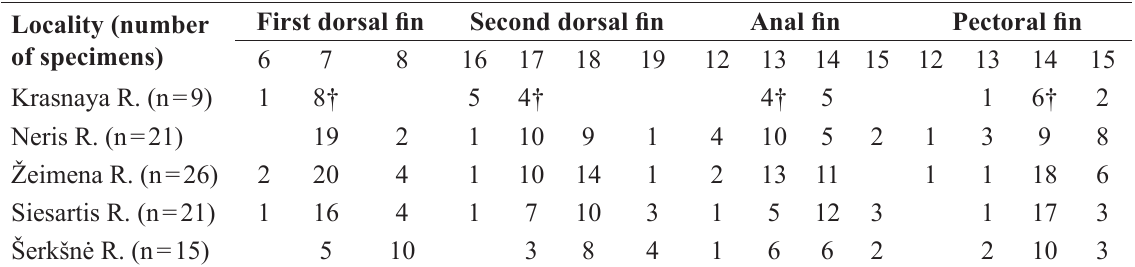
Table 3. Frequency of occurrence of fin-rays counts in Cottus cyclopththalmus sp. nov. Note: † = values for the